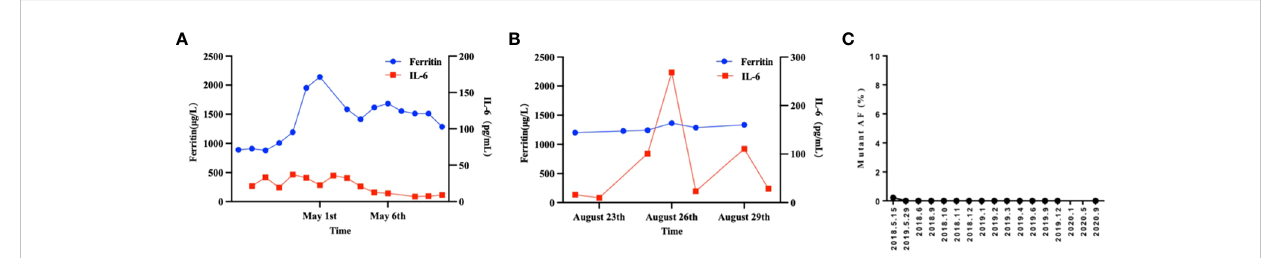
FIGURE 3 The therapeutic response of CAR19 and CAR22 T cell cocktail therapy following ASCT. (A) Dynamic changes in IL-6 and ferritin after CAR-T cell infusion. (B) Dynamic changes in IL-6 and ferritin after CAR19 and CAR22 T cell cocktail therapy following ASCT. (C) Liquid biopsy results. The proportion of circulating tumor DNA mutations at locus TP53 c.376-1G>A was measured and the results were expressed as the ratio (percentage) of copy numbers of the target gene and the internal reference